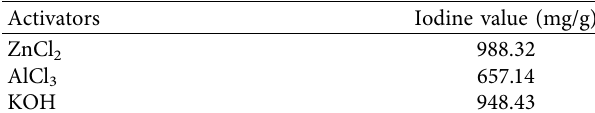
Table 3: Preferred activators.